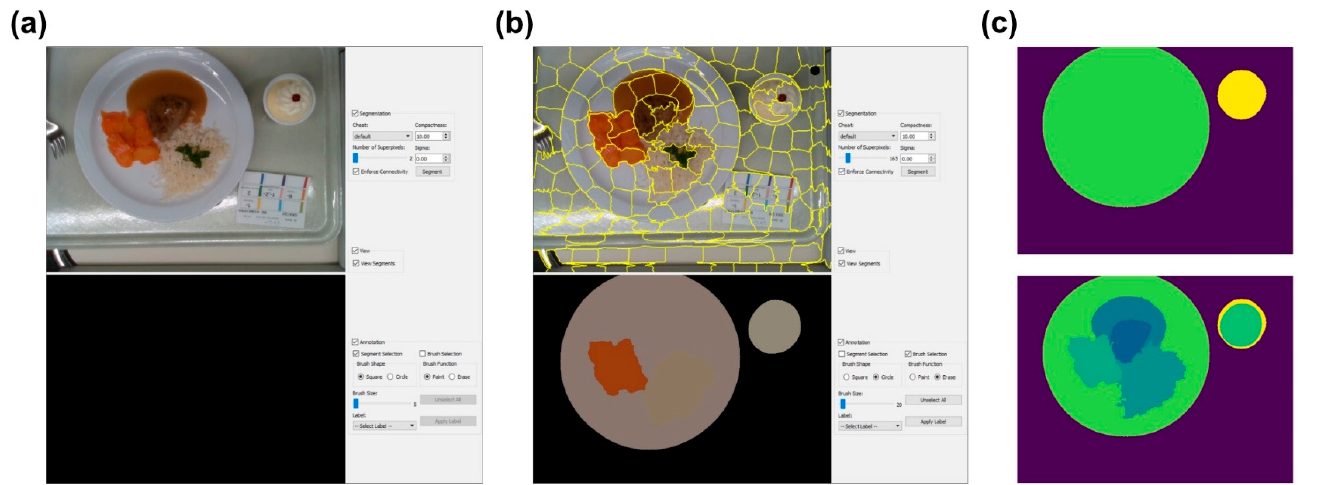
Figure 5. The segmentation tool that was used to provide the ground truth of the segmentation (GT seg ): ( a ) the interface of the segmentation tool; ( b ) the semi-automatic segmentation; ( c ) the segmented plates of the images (up) and food types (bottom).